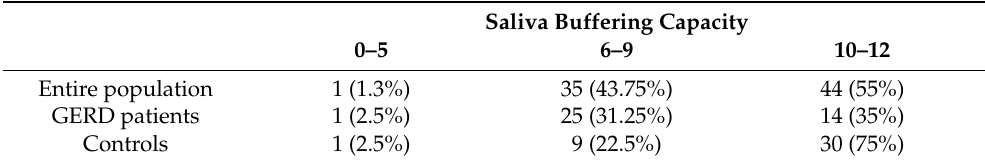
Table 4. Distribution of saliva buffering